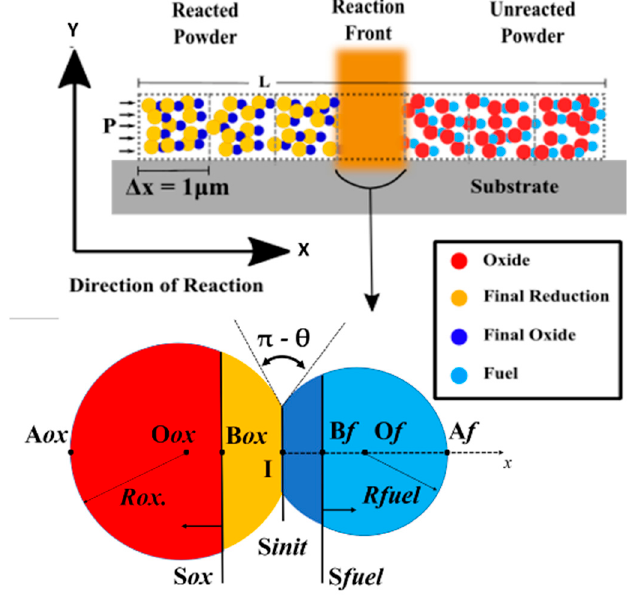
Figure 1. Geometry of the modelled thermite system and main model parameters: top figure, general view of the system, with the reaction front propagating from the left to the right. Lower figure, a magnified view of one fuel/oxidizer particle pair, with its multiple interfaces as the reaction propagates.